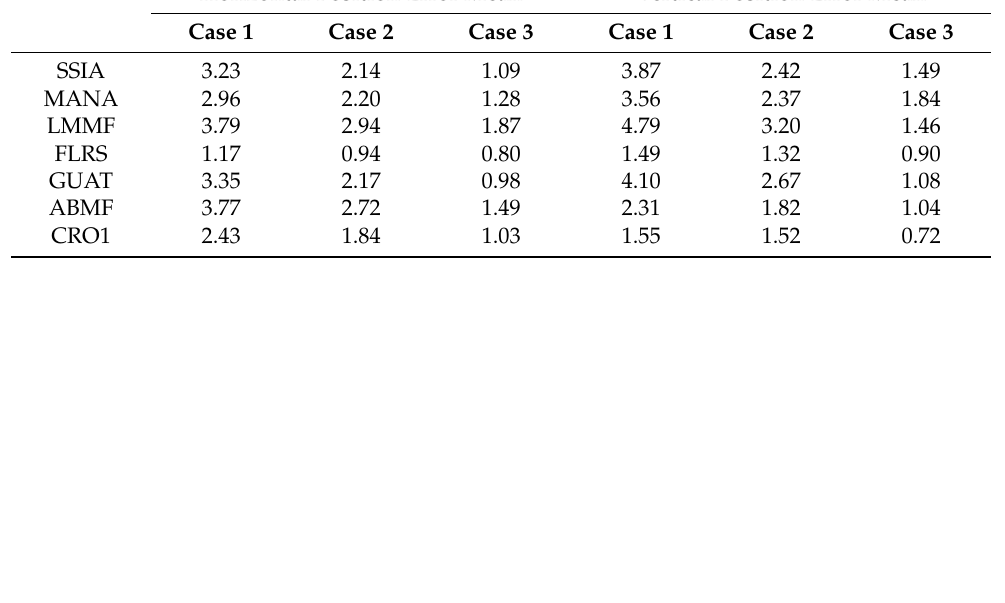
Table 3. One month mean of horizontal and vertical positioning errors in March 2015.